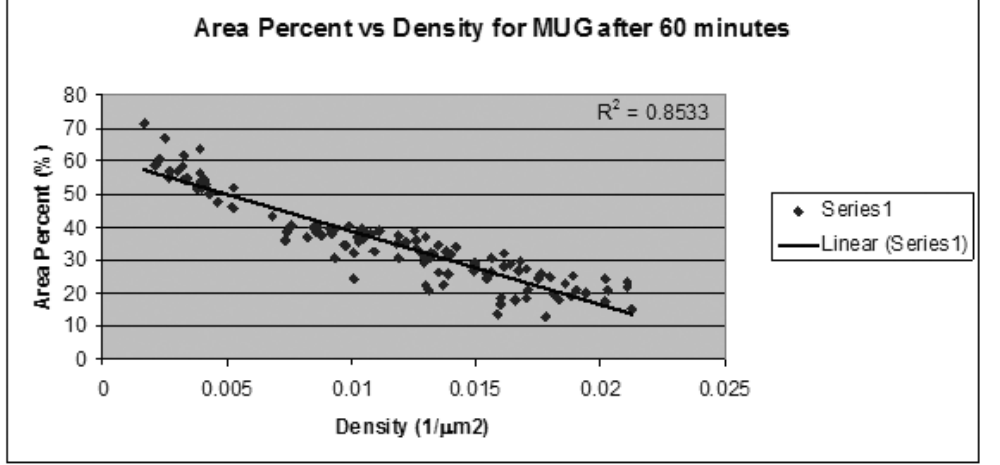
Figure 14: Area Percent vs. Density of wear for MUG after 60